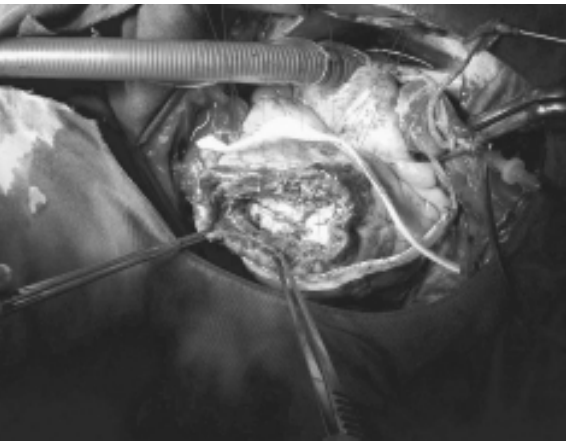
Fig. 2 - Aspecto intra-operatório da correção da rotura do ventrículo esquerdo pela técnica de D’or. Após o remodelamento do ventrículo esquerdo com retalho de pericárdio bovino, o ventrículo é fechado com pontos separados ancorados com duas tiras de